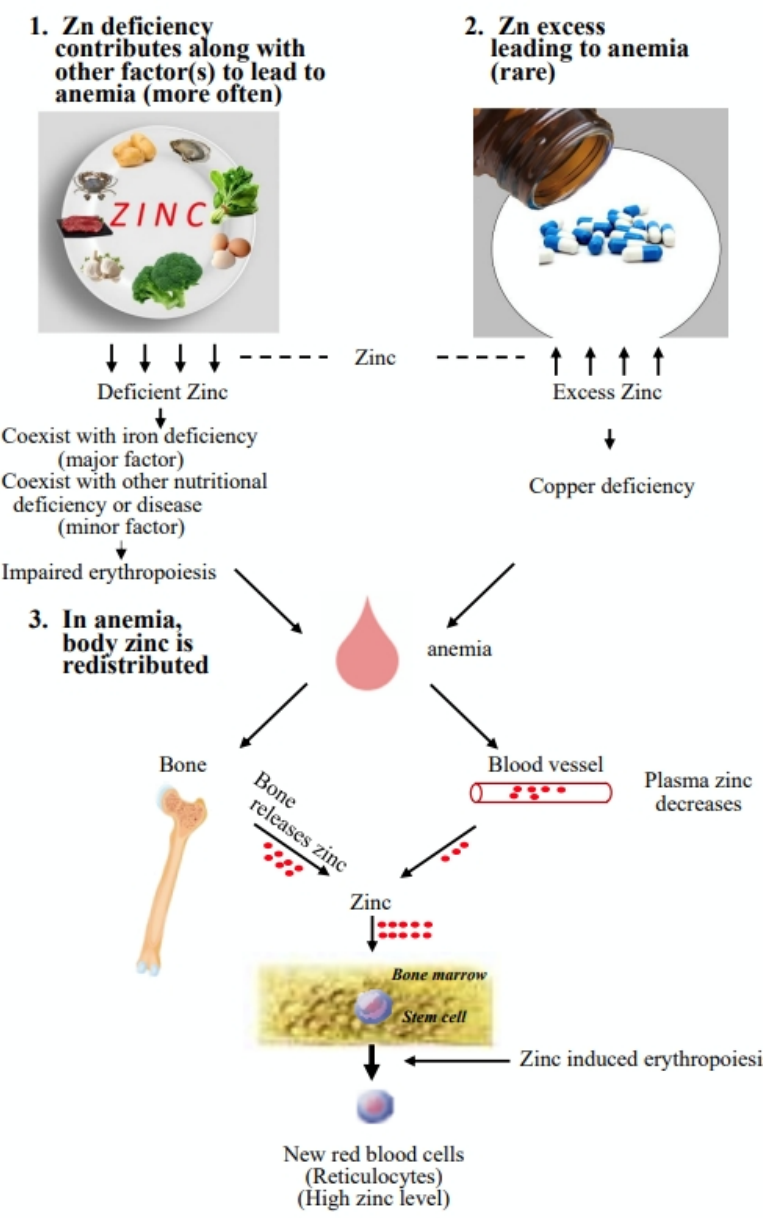
Figure 1. Association of zinc with anemia. Inadequate zinc status (zinc deficiency or zinc excess) could have effects on anemia; at the same time, anemia could render abnormal zinc status in the body.